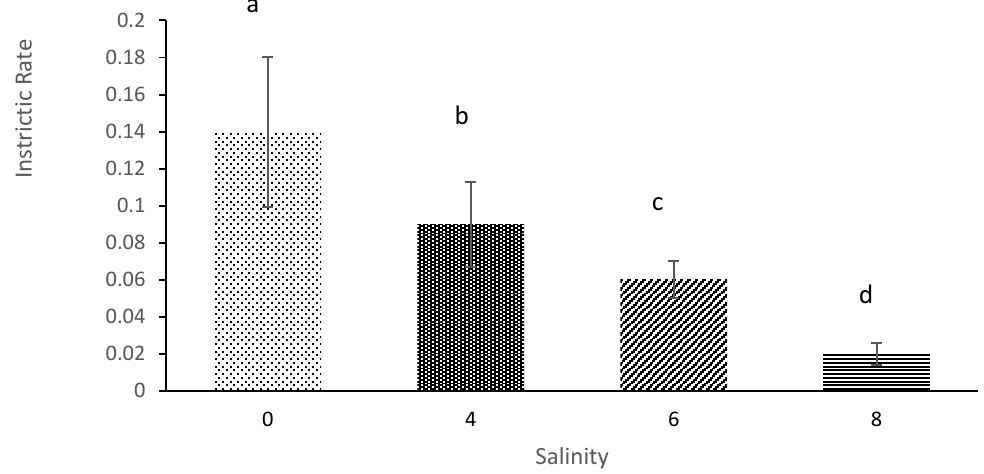
Figure 9. The generation time of M. macrocopa for different salinity treatments. The different small letters indicate significant differences between different salinity treatments ( p > 0.05).